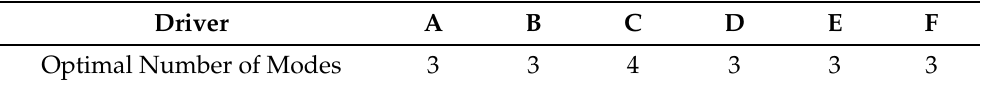
Table 1. Identified number of modes from consistent variable selection for each